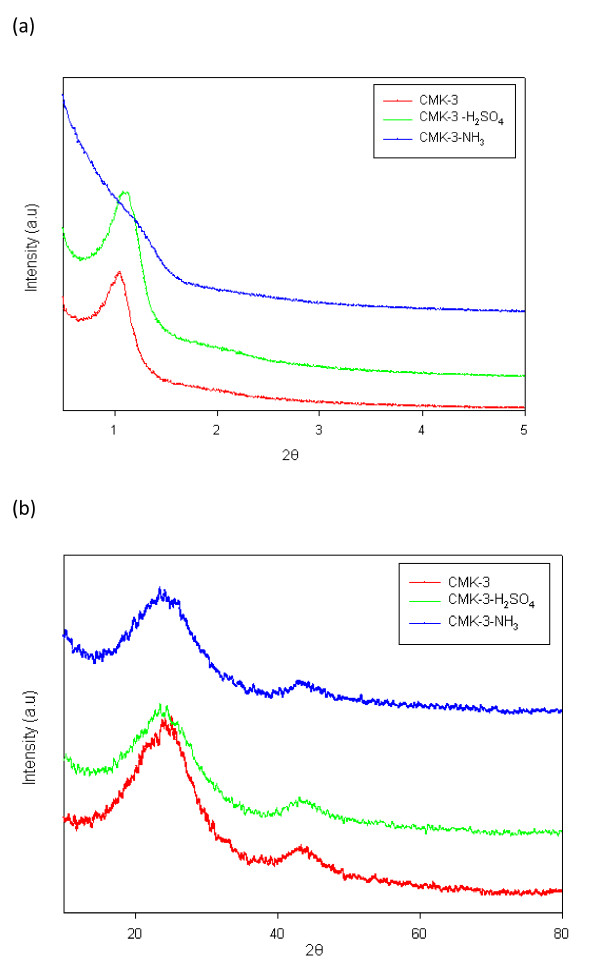
XRD patterns of CMK-3, CMK-3-H2SO4, and CMK-3-NH3 samples: (a) low-angle and (b) high-angle XRD patterns.